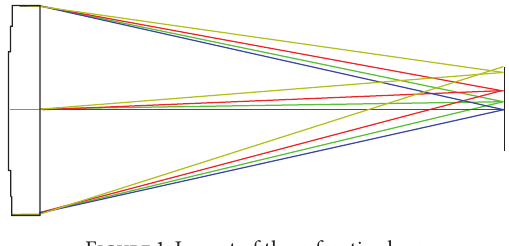
Figure 1: Layout of the refractive lens.